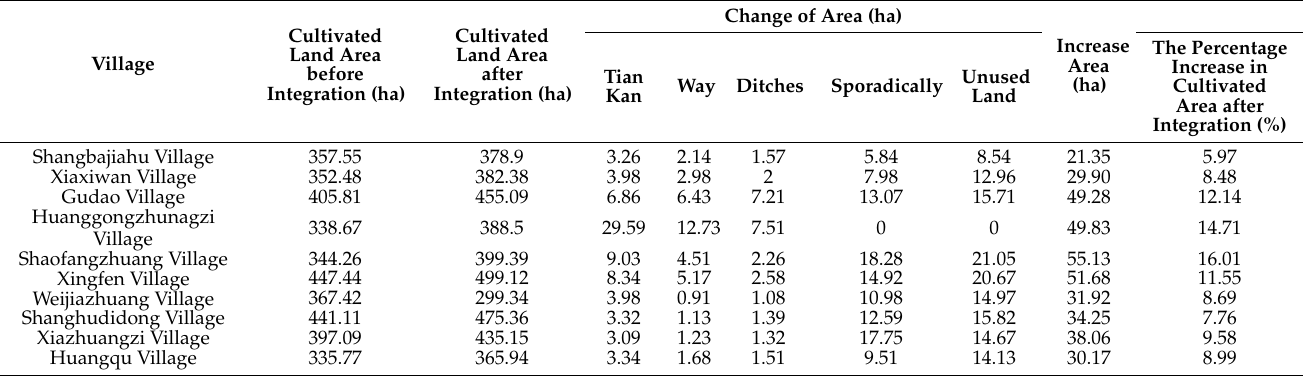
Table 2. Integration of each